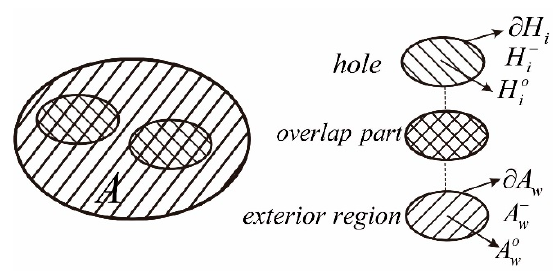
Figure 2. Components in the practical definition of regions with holes.